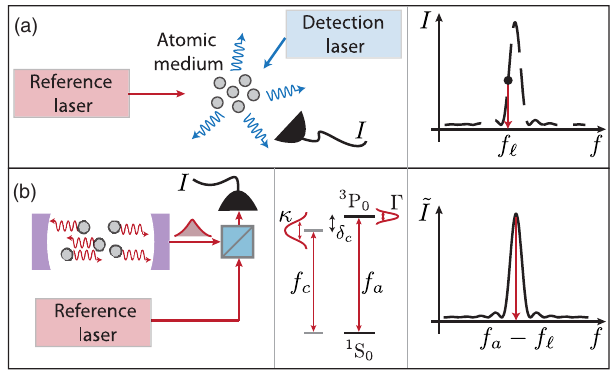
FIG. 1. Passive and active optical frequency references. (a) In a passive optical frequency reference, the clock transition in the atomic medium is driven by radiation from a laser at frequency f l . The laser frequency is then determined relative to the clock transition frequency through a population measurement of the two clock states using a fluorescence signal ( I ) obtained from a separate atomic transition. The fluorescence signal provides information about the atomic response at frequency f l , which can be used to stabilize the frequency of the laser. (b) In an active optical frequency reference, light is collected directly from the atomic clock transition. This light can be compared to the reference laser by forming a heterodyne beat note. The power ˜ I spectral density of the resulting signal ( ) provides information about the atomic system at all offset frequencies from f l within a large detection bandwidth set by the detection electronics. In our system, we use 87 Sr atoms emitting into a high-finesse optical cavity on a roughly 1-mHz-linewidth clock transition as the active atomic medium. The clock transition frequency f a is nearly equal to a cavity resonance frequency f c , up to a tunable offset δ c ¼ f a − f c . The cavity linewidth κ ¼ 2 π × 145 kHz greatly exceeds the atomic linewidth, placing the system in a highly damped, “ superradiant ”